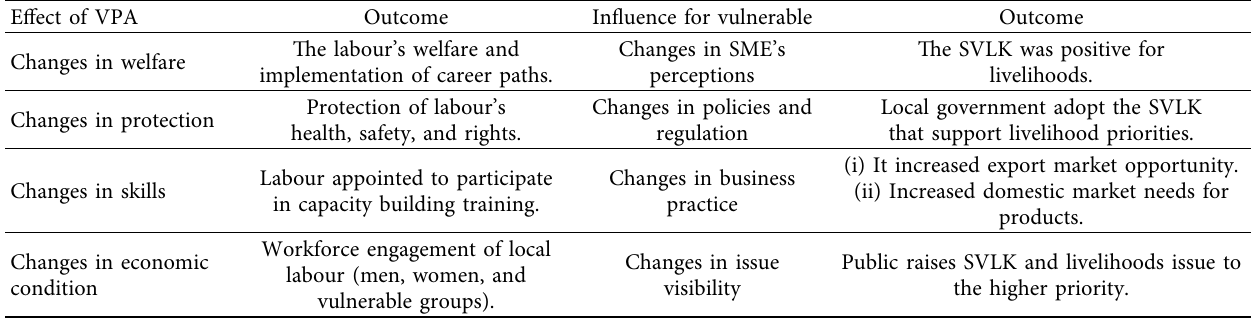
Table 1: The effect of the VPA and influence for vulnerable by theory of change